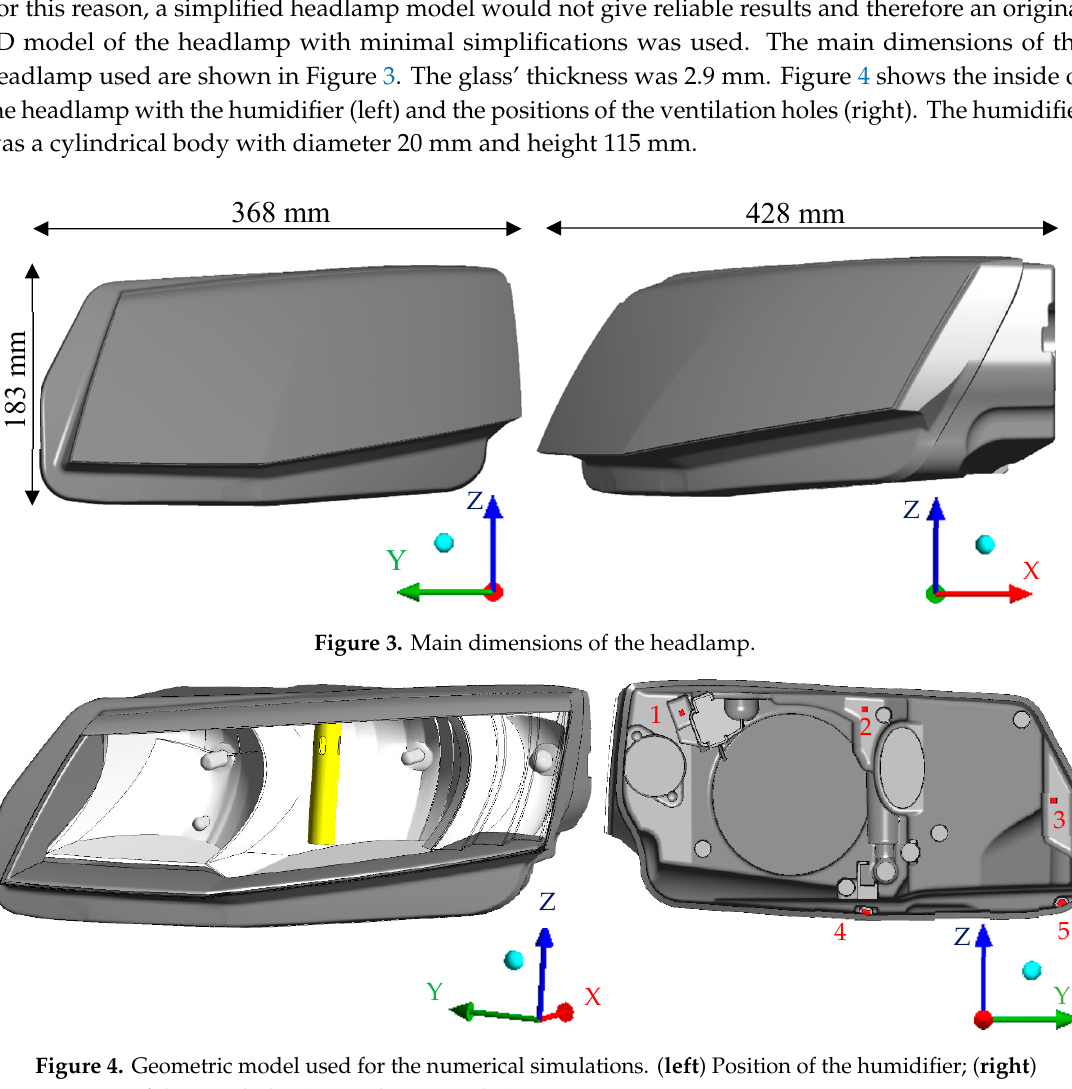
Figure 2. Testing rig used for fogging/defogging (1: pressurized air; 2: regulators; 3: humidifier; 4: headlamp).